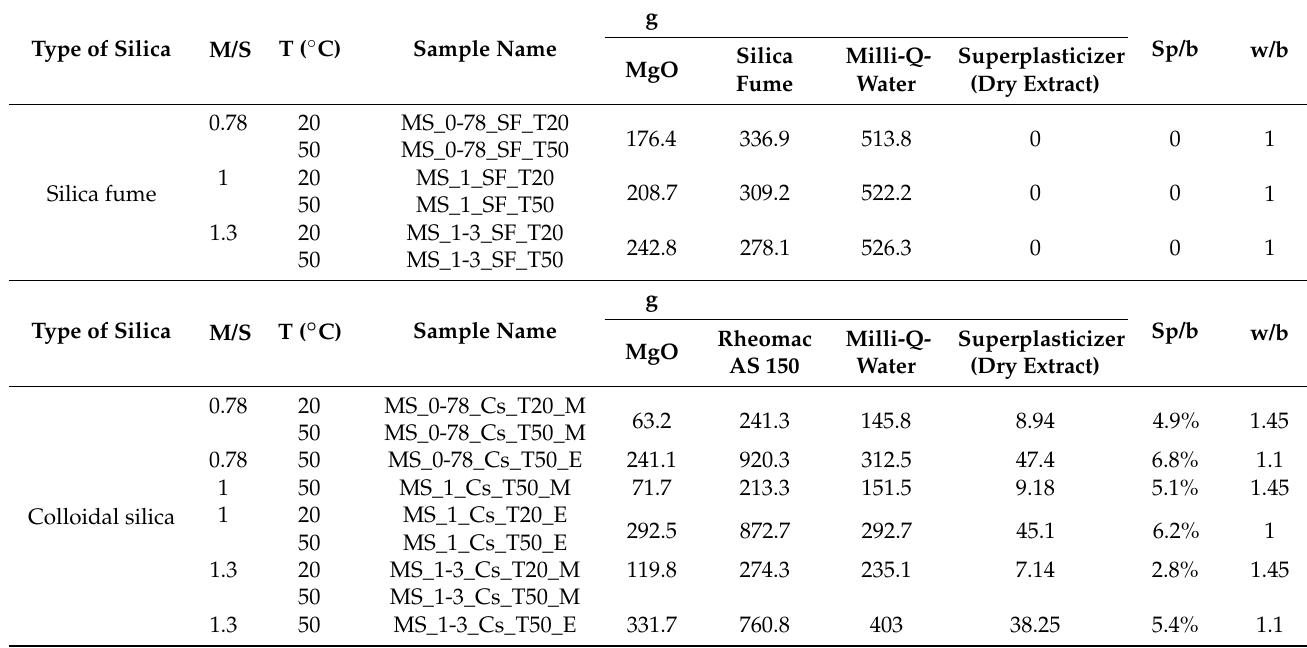
Table 1. Mix proportions. Sp/b represents the mass percentage of superplasticizer against